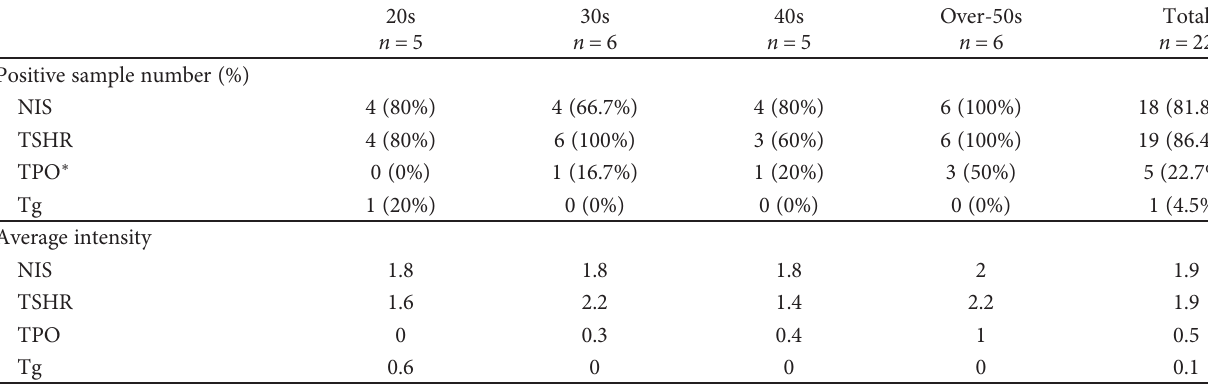
Table 1: Expression of thyroid-related proteins in the thymus according to the